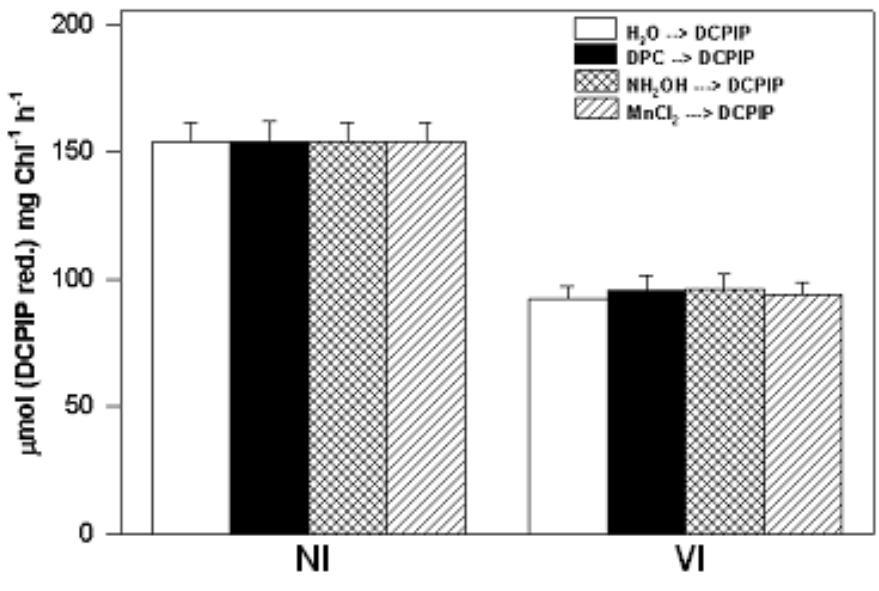
Fig. 3. Effect of various exogenous electron donors on PSII activity (H from noninfected (NI) and virus-infected (VI) Vitis vinifera leaves (means ±SE; n